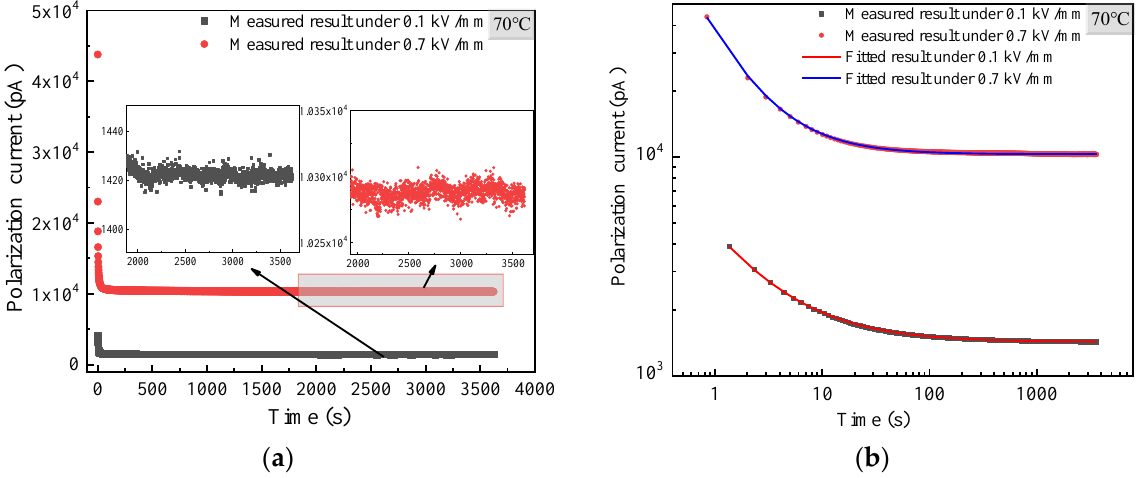
Figure 9. Current TDS of surface modified MgO powder at 70 °C. ( a ) Linear coordinate; ( b ) double logarithmic coordinate.